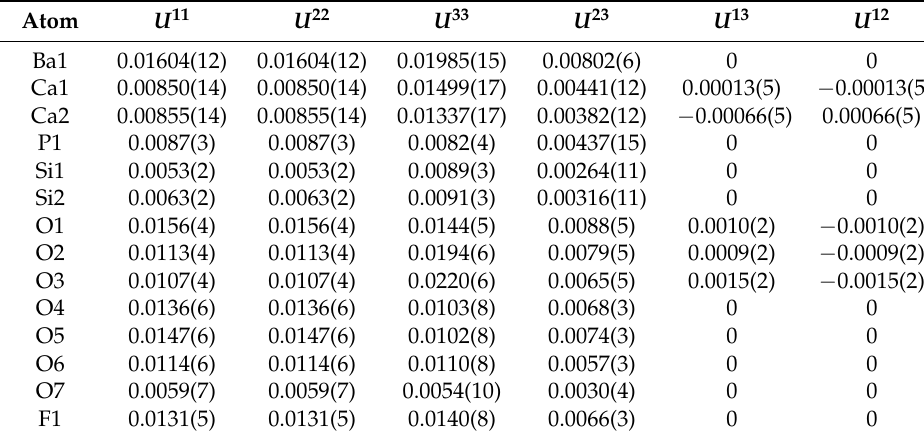
Table 4. Anisotropic displacement parameters U ij for ariegilatite.